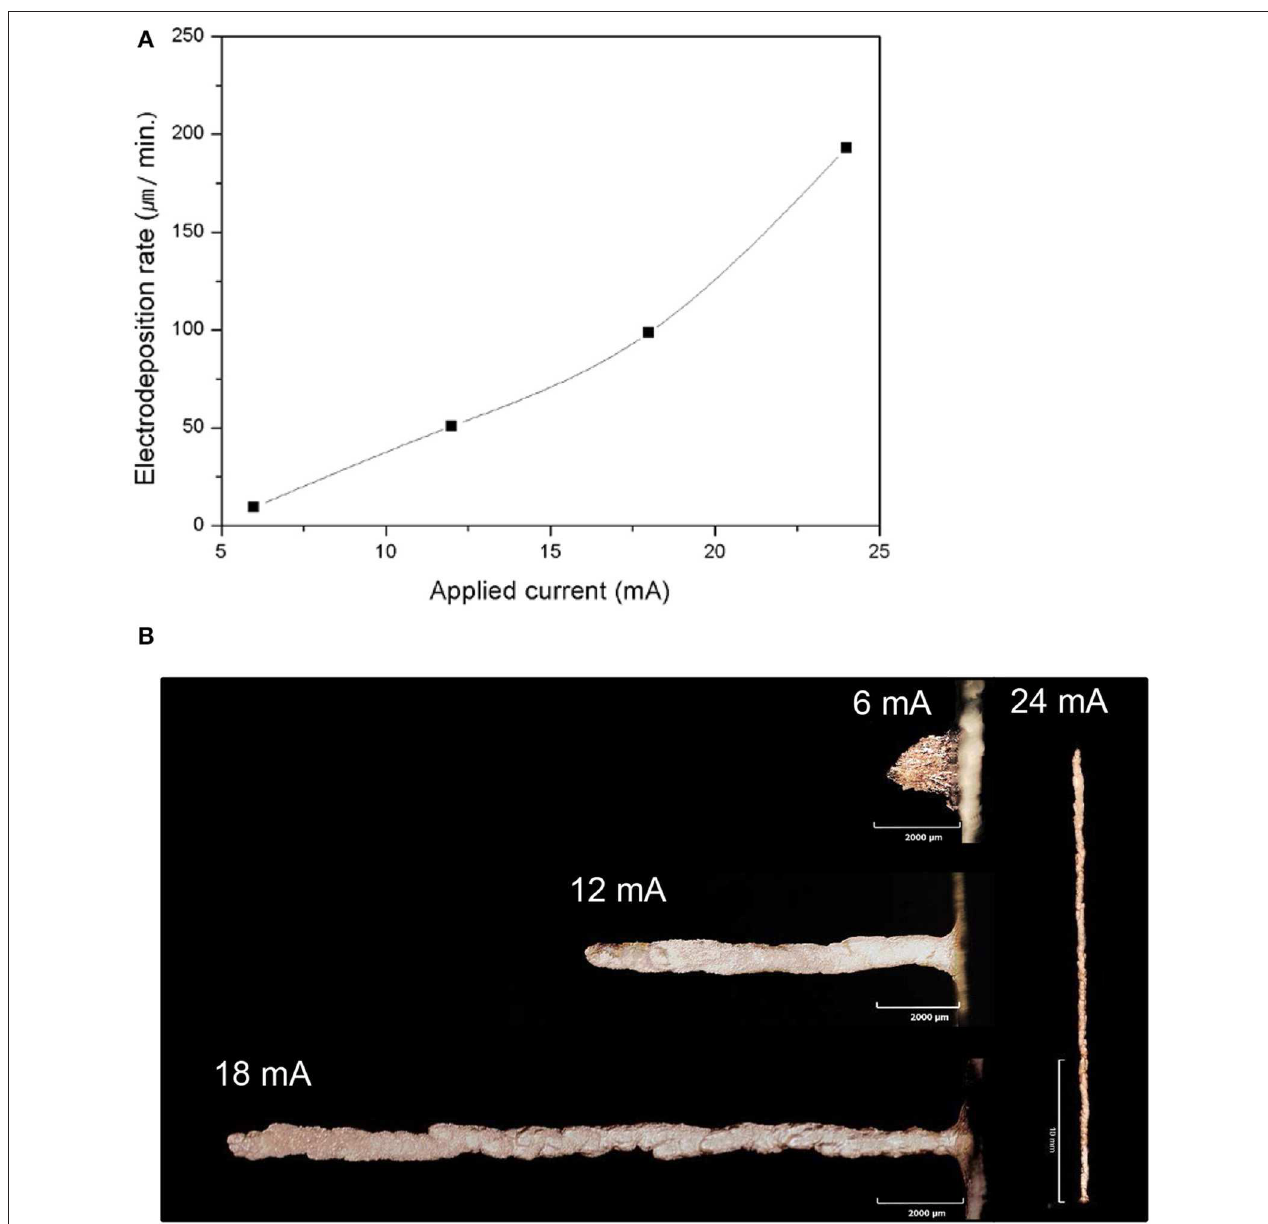
FIGURE 3 | Electroplating characteristics according to the applied current, in which the small letters denote the following: (A) electrodeposition rate depending on the applied current; (B) directional growth of the pillars depending on the applied